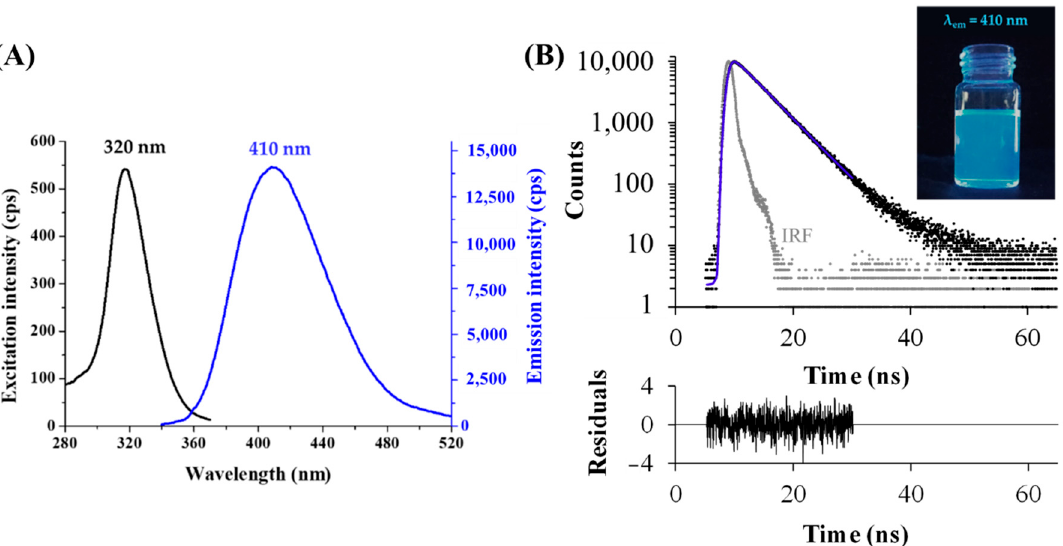
Figure 2. ( A ) Fluorescence excitation and emission spectra of the purified Tyr-AgNCs (T = 25 °C, c Ag = 10 μ M). ( B ) Fluorescence decay profile (measured: black dots, fitting: blue line, instrument response function (IRF): grey dots; λ ex = 295 nm, λ em = 410 nm, χ 2 = 1.09) with the photo of the Tyr-AgNCs under UV-lamp ( λ max of lamp = 365 nm).